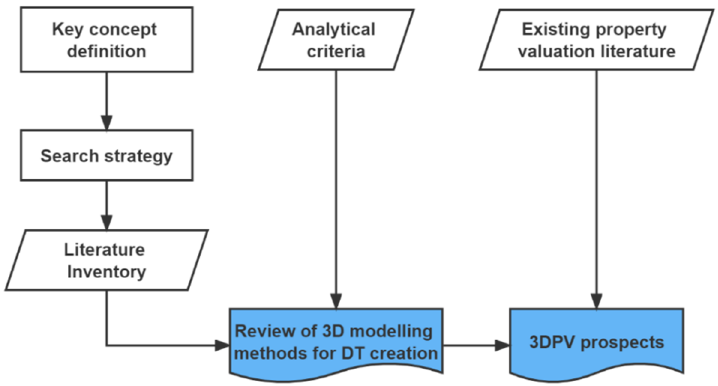
Figure 4. Overarching methodology.